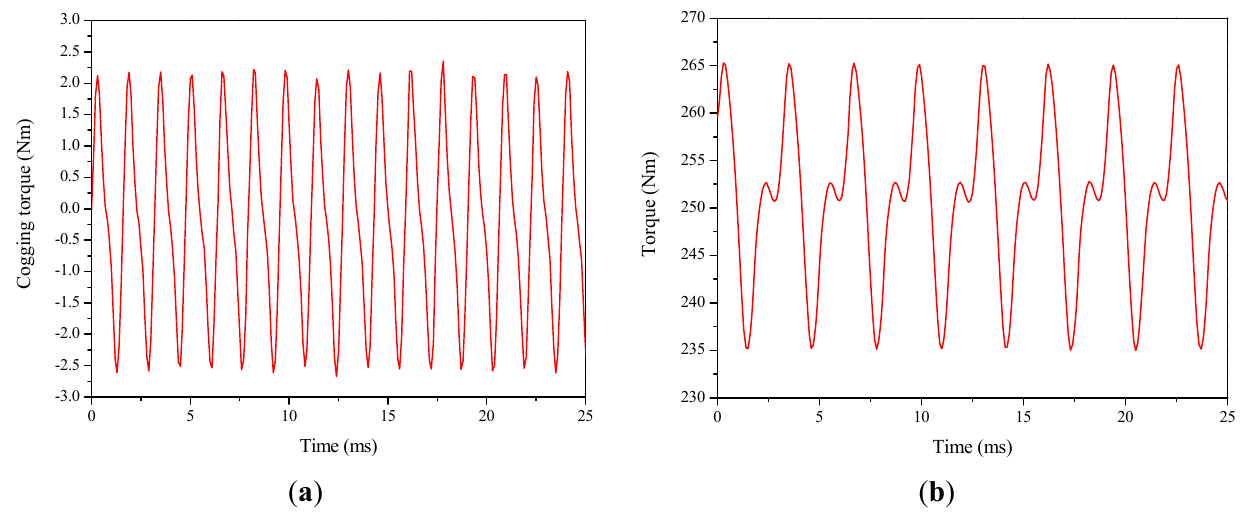
Figure 11. Torque behavior@450 rpm: ( a ) cogging torque with on load; and ( b ) rated torque with i = 0 control. d